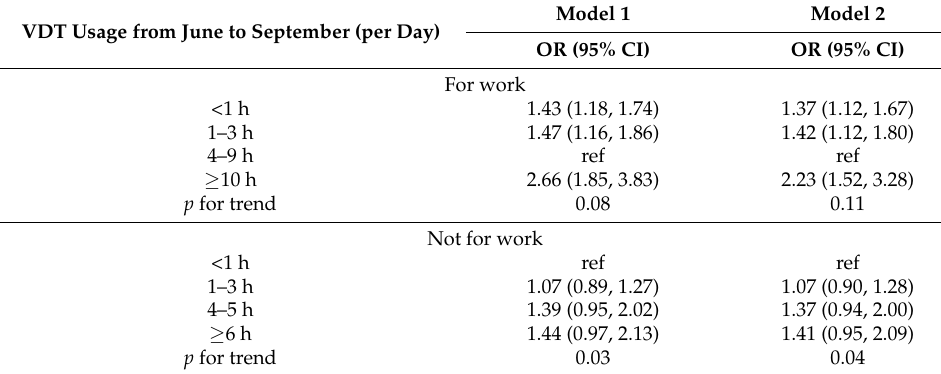
Table 3. Association between the VDT usage and severe psychological